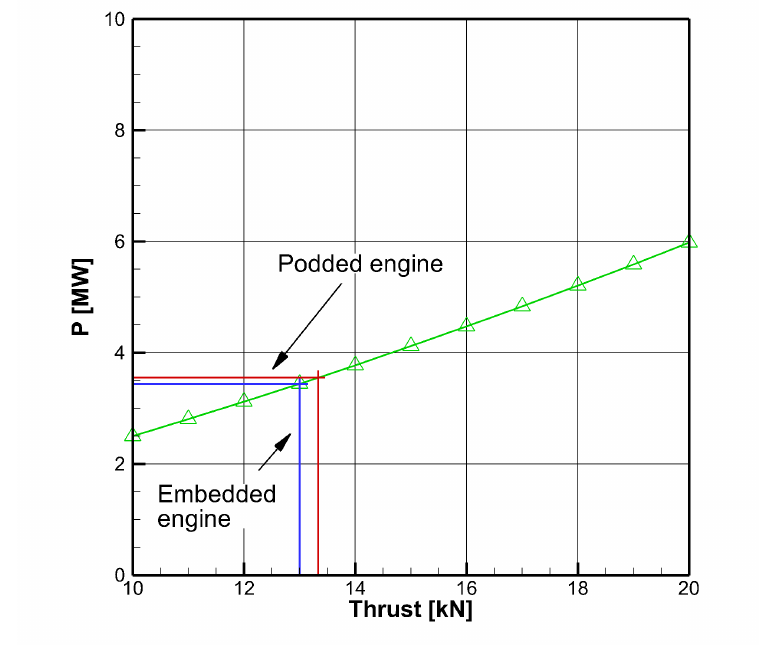
Figure 14. Propulsive power consumption without BLI